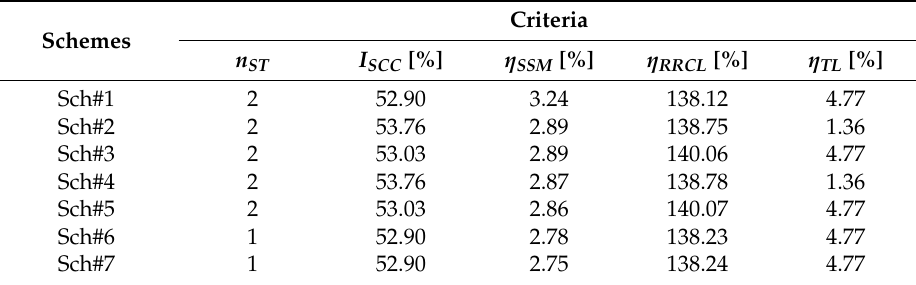
Table 9. Criteria of each feasible scheme in Case 2.